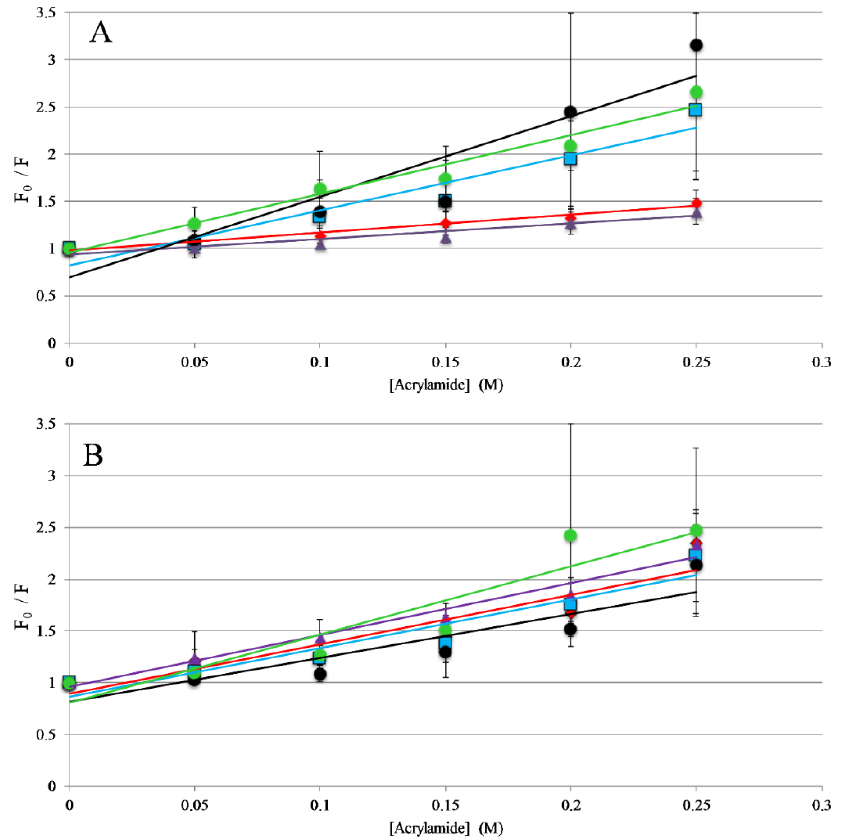
Figure 3. Trp Emission Quenching by Acrylamide: Fluorescence quenching of AP3 and derivatives by acrylamide ( A ) in the presence of 250 µ M 75:25 PC: PG vesicles or ( B ) in the absence of lipid vesicles (in buffer solution). For both graphs, AP3 is shown as red diamonds, AP3K as blue squares, APX as purple triangles, APX-17 as black circles, and APX-12 as green circles. Lines represent linear fits of the data. Data shown are corrected for background fluorescence, inner filter effects, and are averages of at least three replicate samples. Error bars represent the standard deviation of these data.